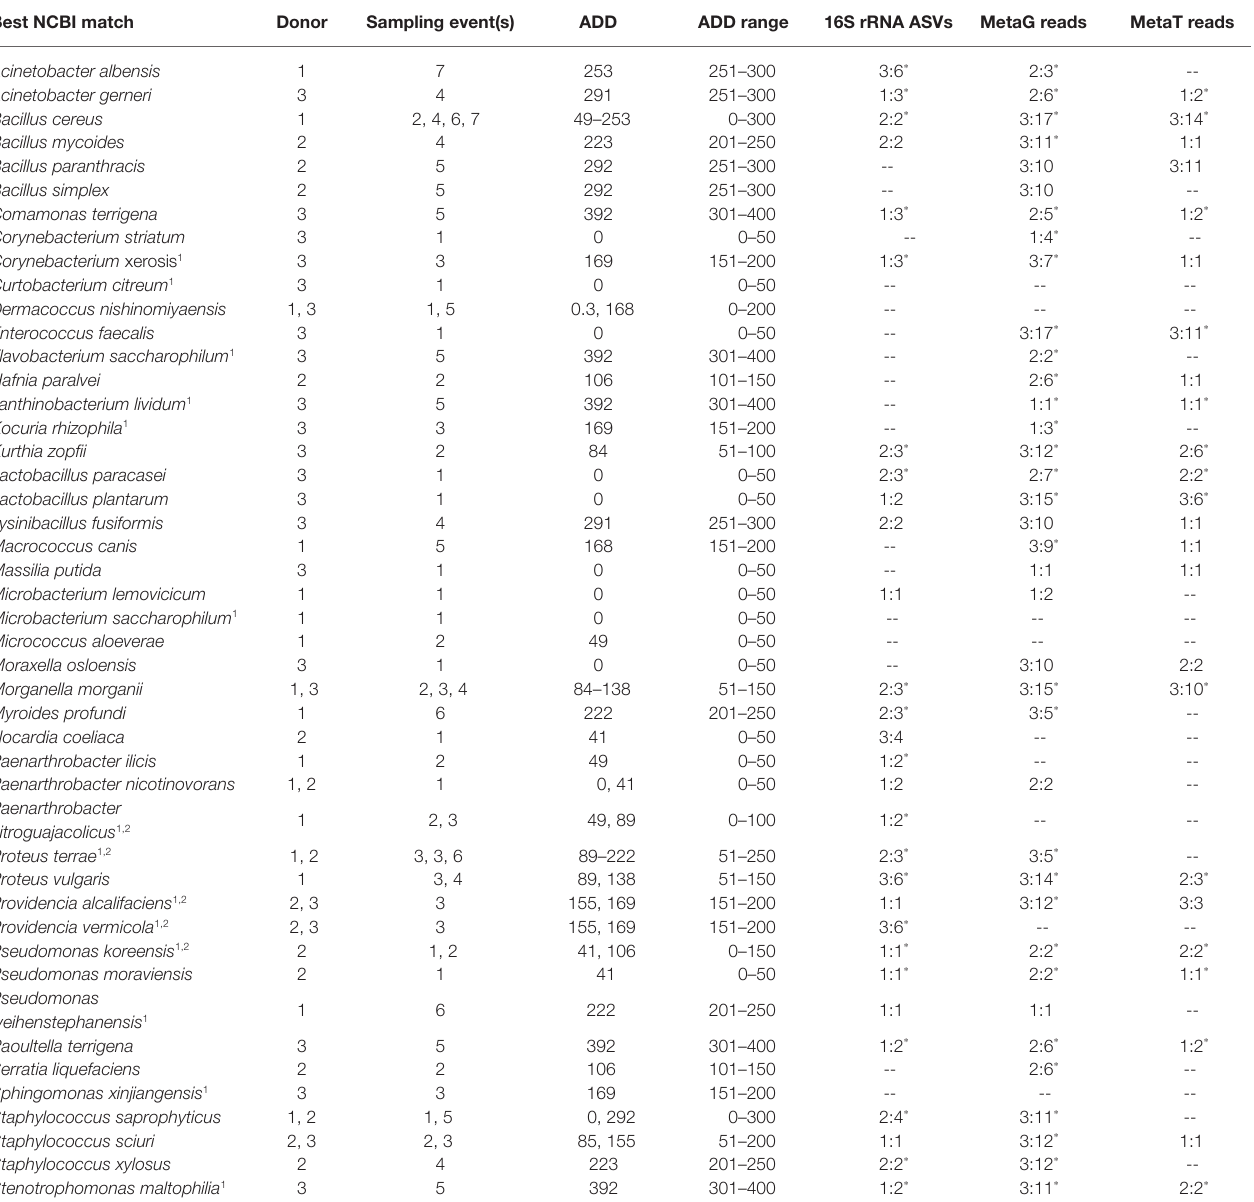
TABLE 2 | Species of bacteria recovered from three human donors undergoing decomposition at the FOREST facility in Cullowhee, NC including a name for each based on NCBI taxonomy resulting from BLAST analyses, the donor(s) and sampling event(s) that yielded each species, asnd the accumulated degree day(s; ADD) at the time(s) of